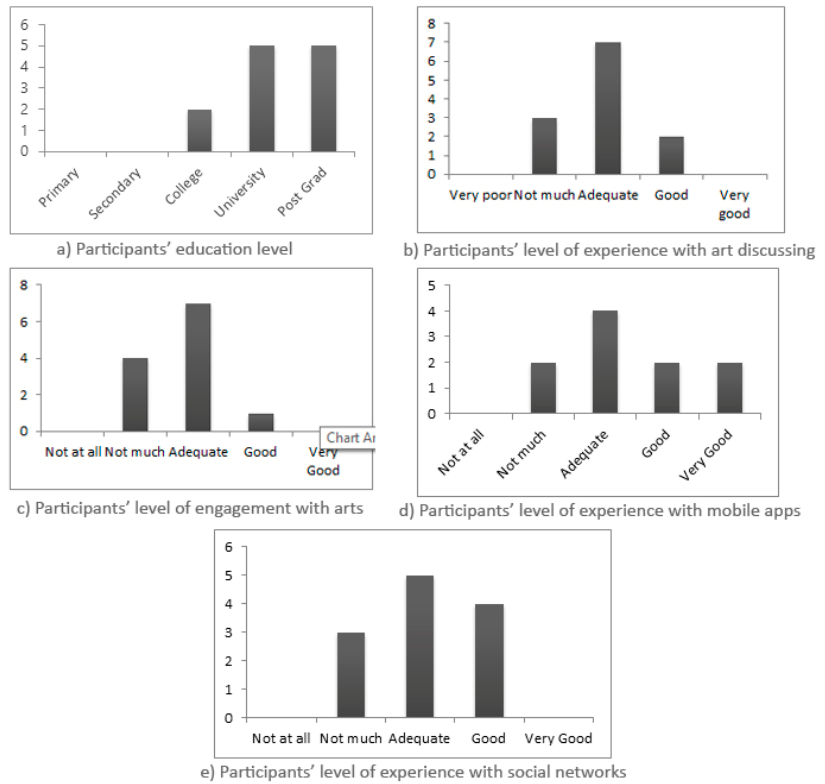
Figure 19. Statistical data regarding characteristics of the participants related to their ( a ) education level, ( b ) experience with art discussion, ( c ) level of engagement with art, ( d ) experience with mobile apps, and ( e ) experience with social networks.